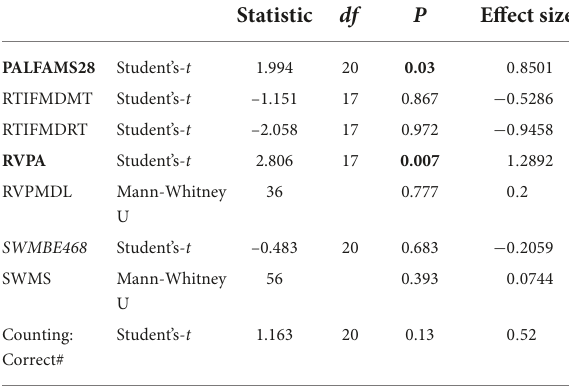
TABLE 3 Comparison of Cambridge Neuropsychological Test Automated Battery (CANTAB) between cerebral small vessel disease (CSVD) patients and age-matched controls